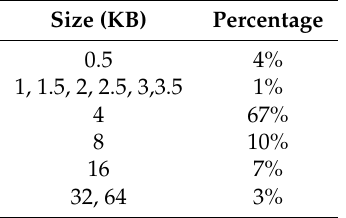
Table 2. Distribution of writes in terms of size.